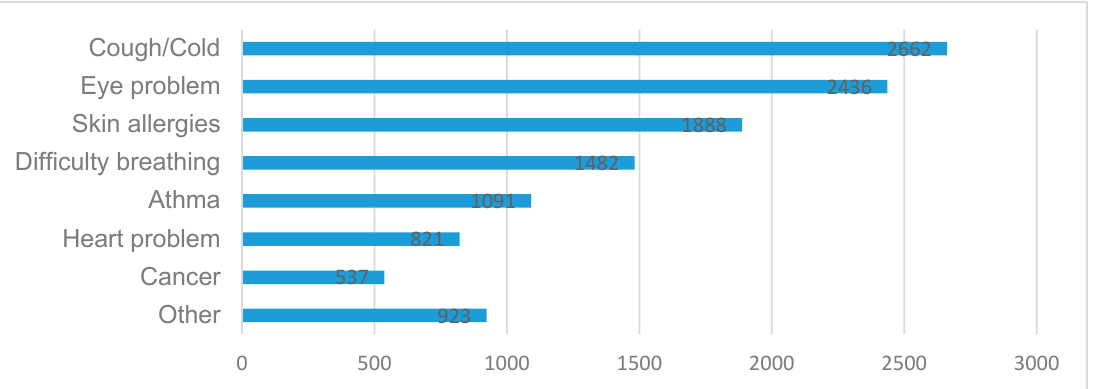
Figure 1. Respondents’ perceived health risks from air pollution: the top three needing more attention.